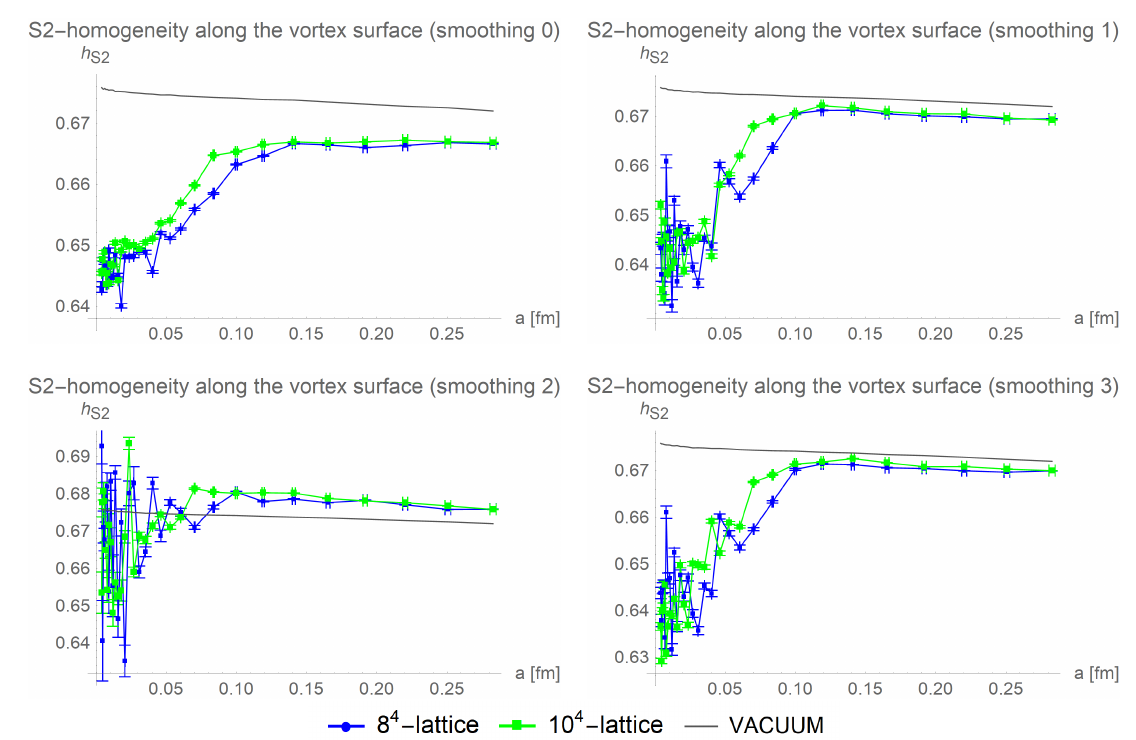
Figure 10. Averaged over 100 configurations, the S2-homogeneity along the vortex surface is compared for different lattice sizes and smoothing procedures after one cooling step. Observe that cooling increases the overall homogeneity on the vortex surface.